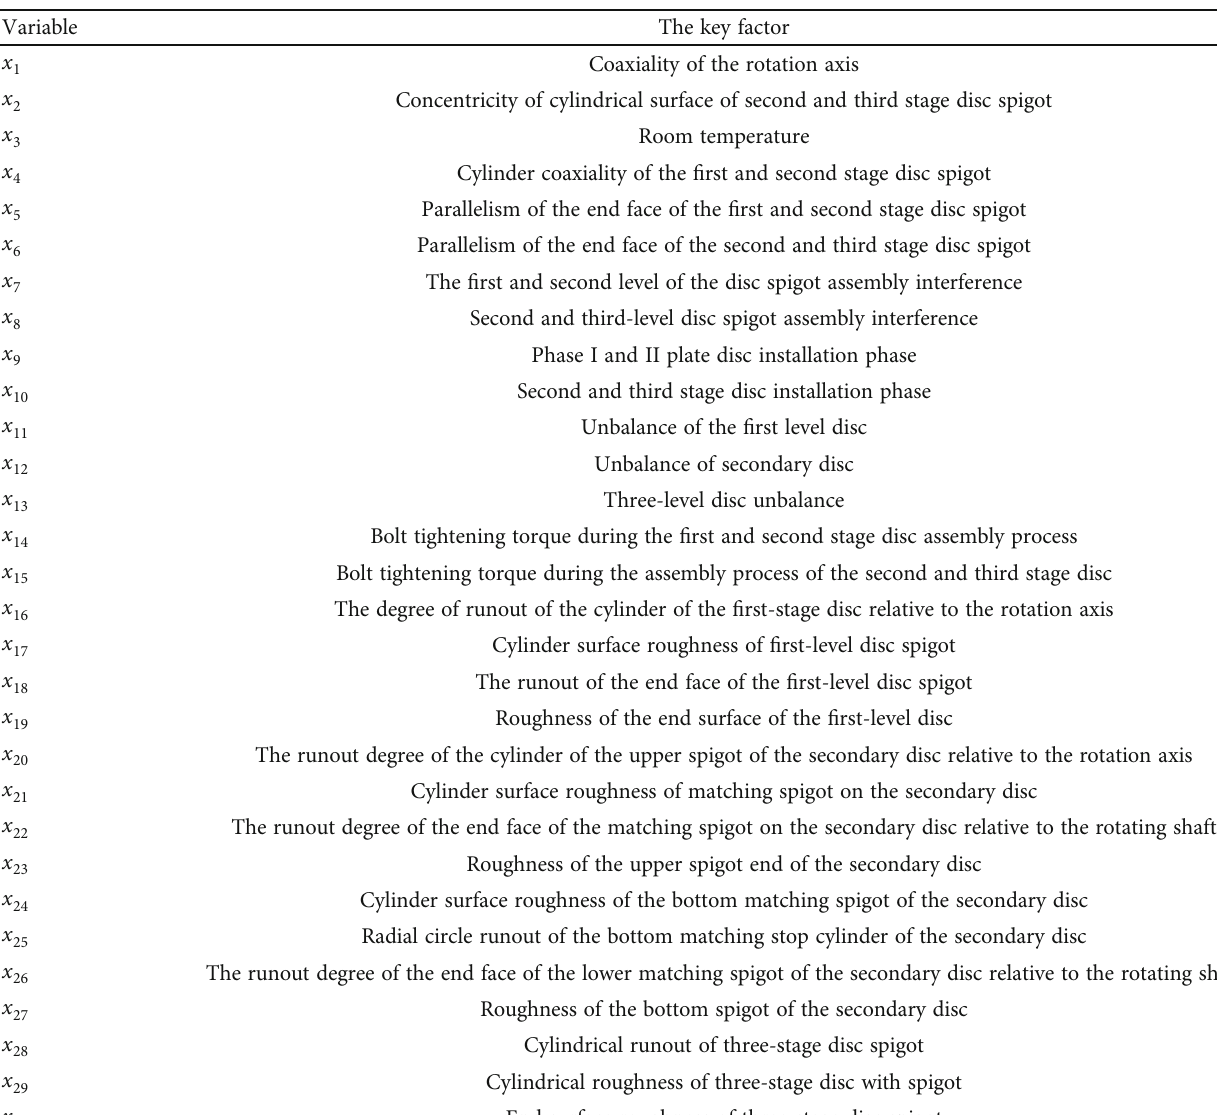
Table 18: Key factors of unbalanced